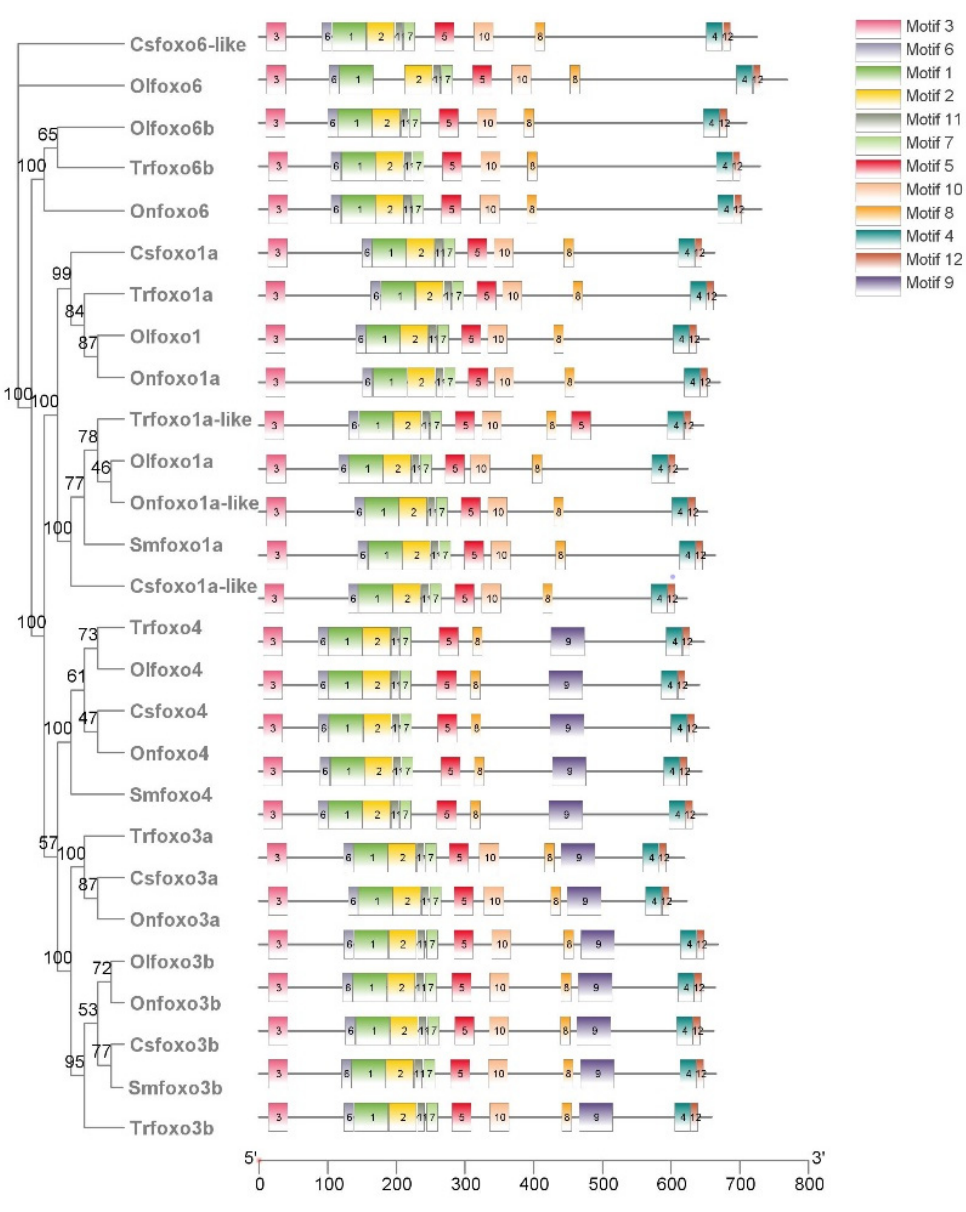
Figure 3. Structure and motif analysis of Foxo proteins in five fish species: Chinese tongue sole (Csfoxo), medaka (Olfoxo), turbot (Smfoxo), Nile tilapia (Onfoxo), and fugu (Trfoxo).